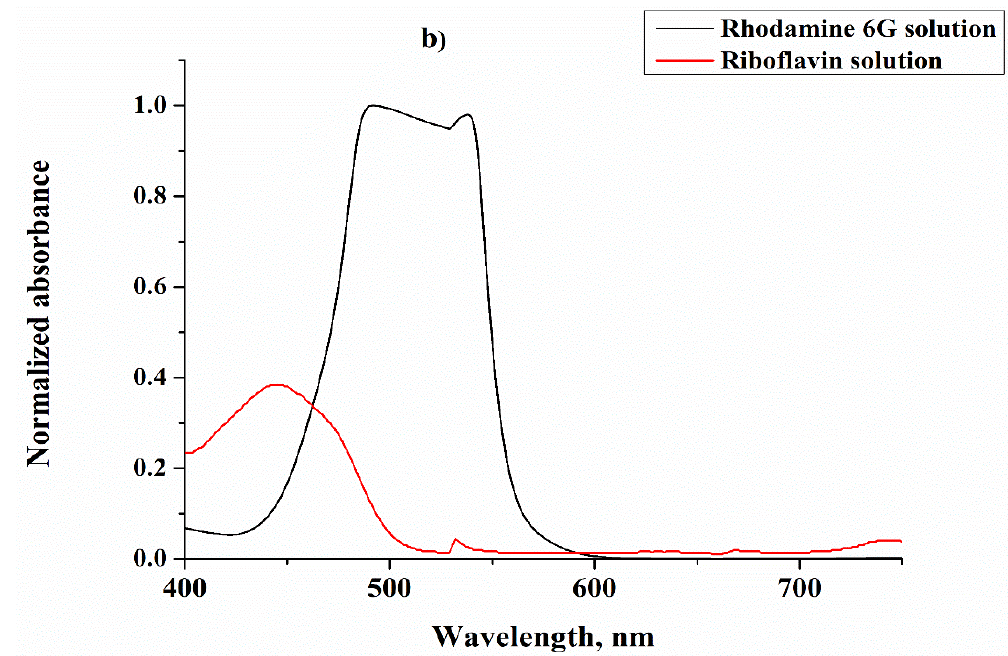
Figure 6. Normalized absorbance of the gold nanoisland SERS substrate: ( a ) clean substrate, and with riboflavin and R6G solutions; ( b ) normal absorbance of analyte solutions.